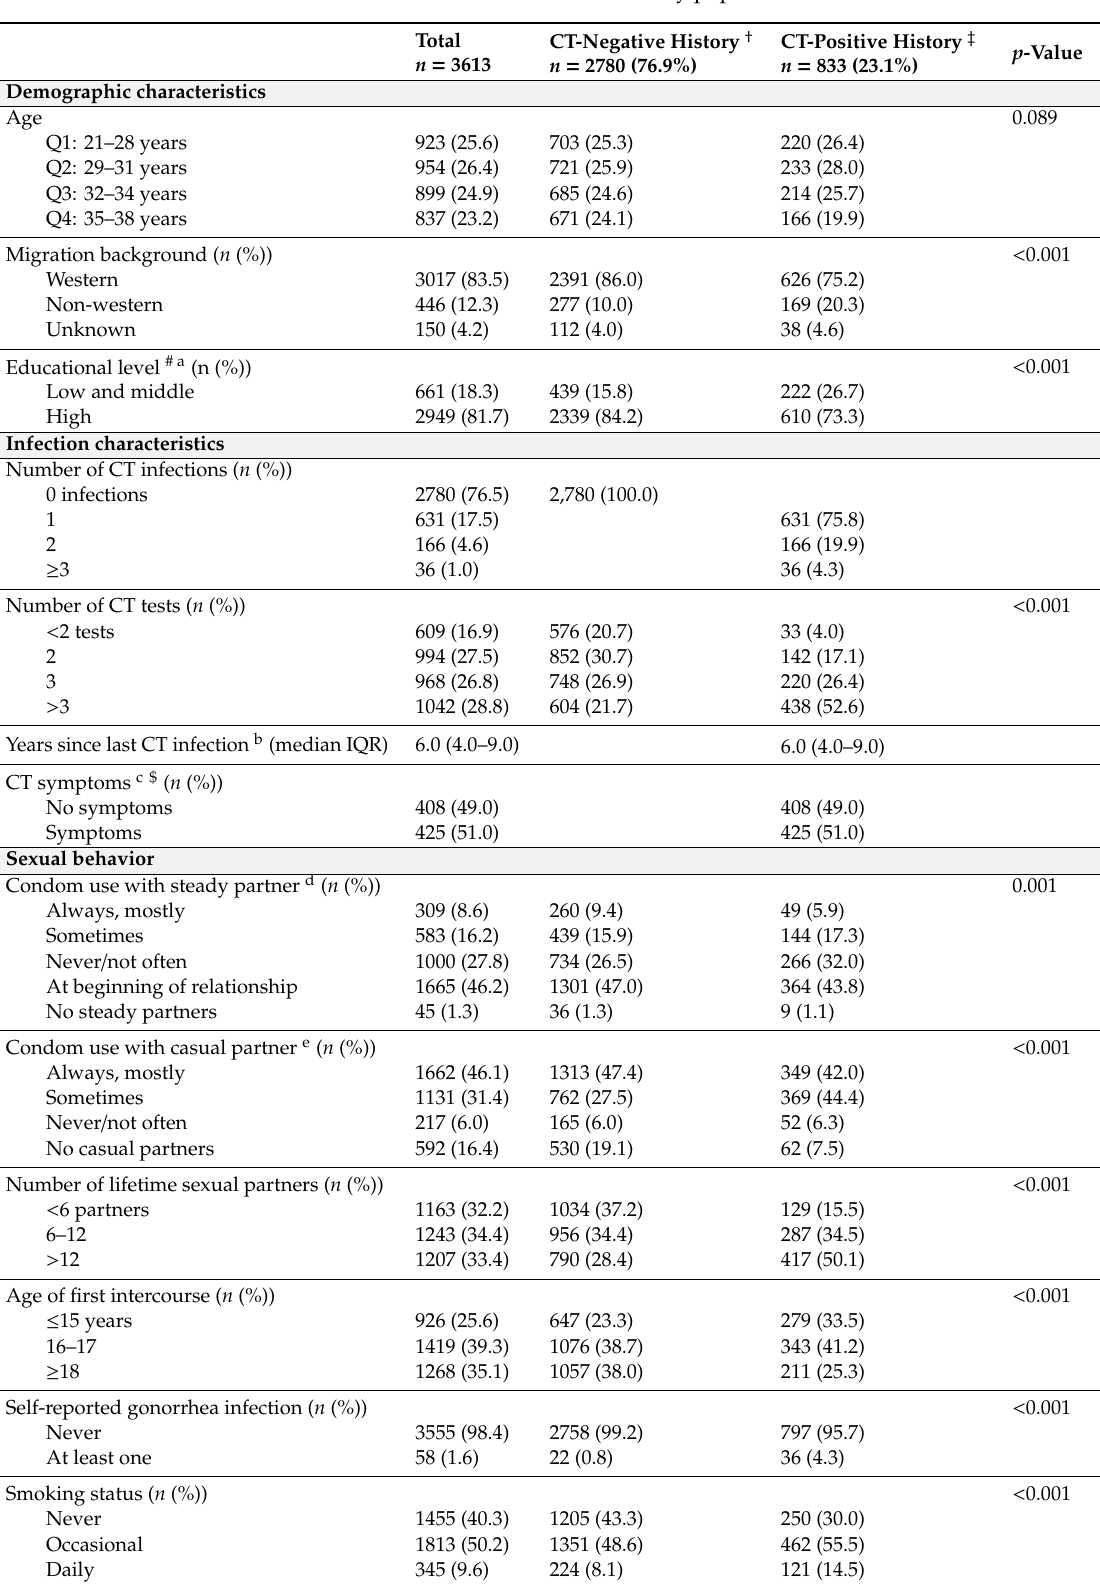
Table 1. Main characteristics of the study